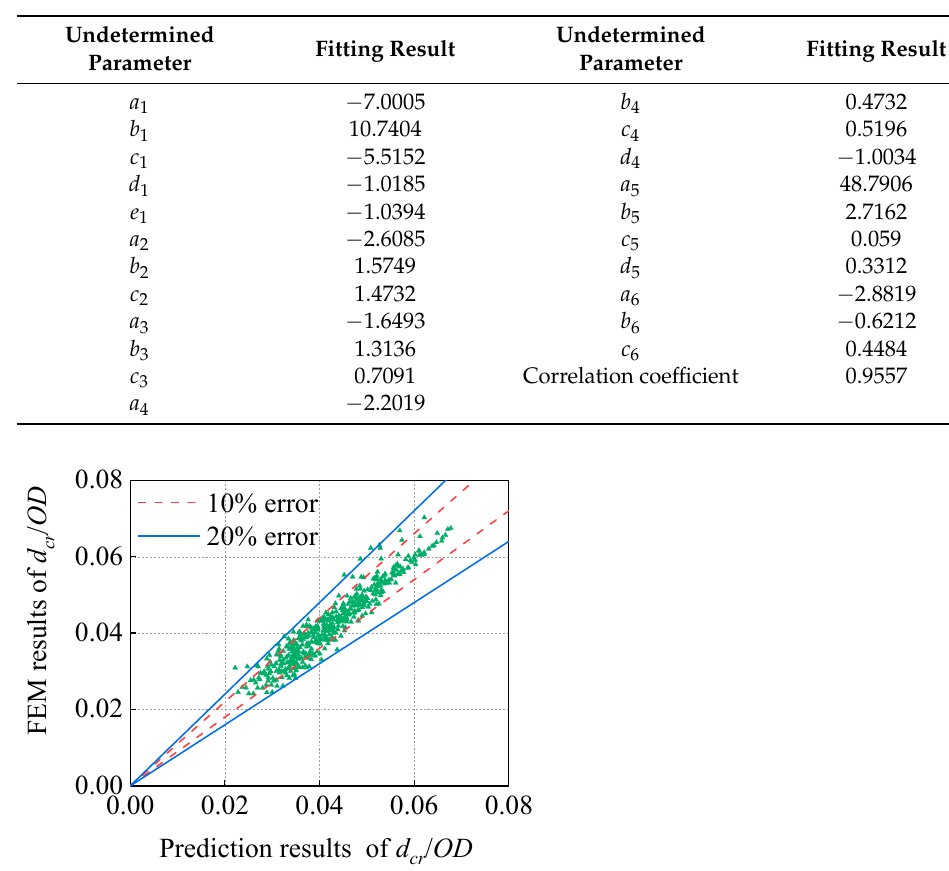
Table 6. Fitting results of parameters.